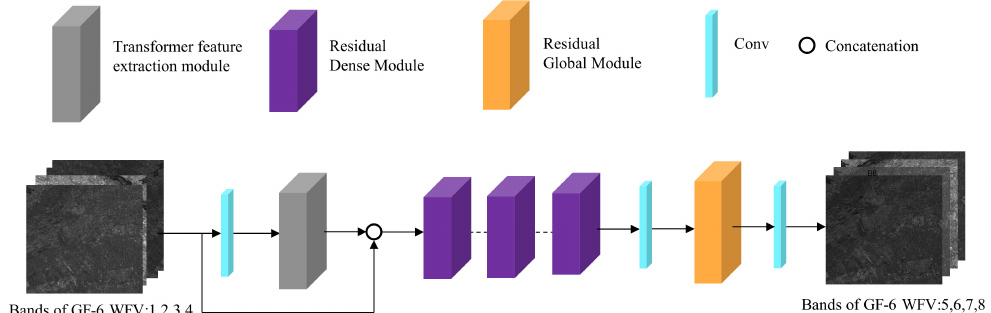
Figure 1. Network architecture of our SRT.